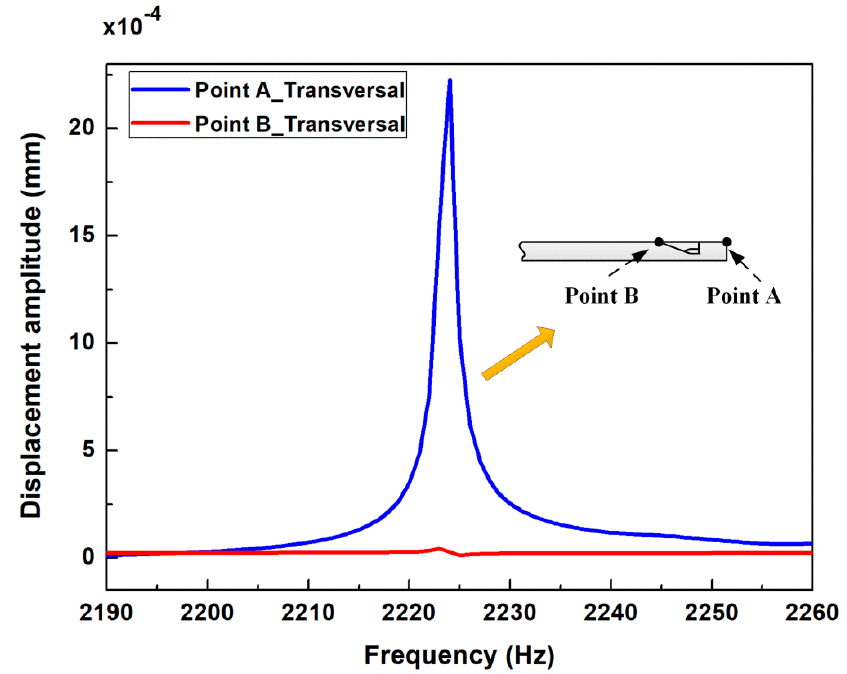
Figure 5. The transverse amplitude of an actuator with a beam tip of 9 mm.